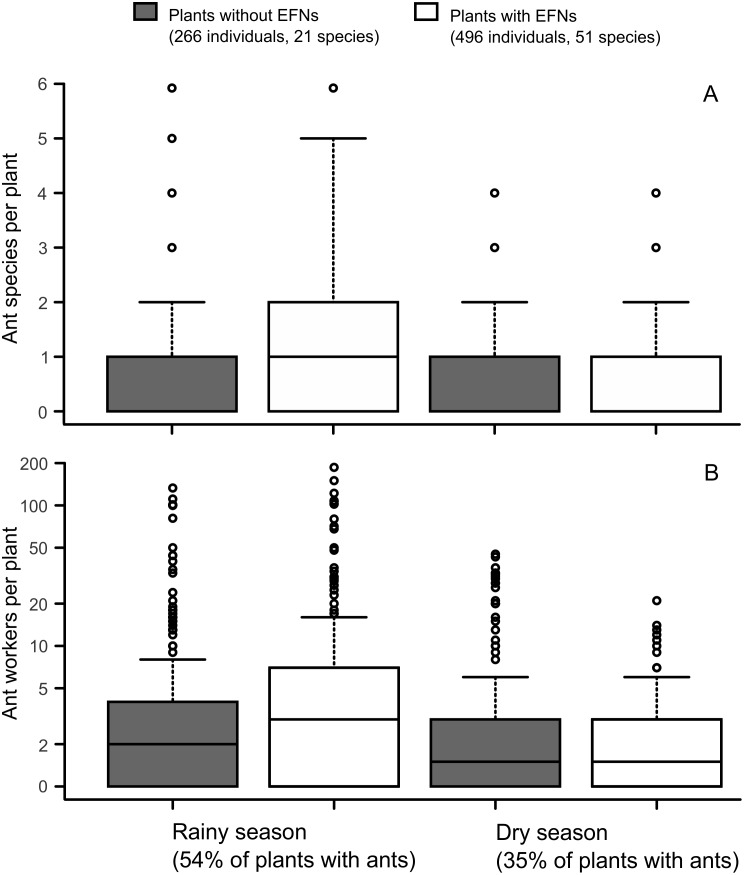
Seasonal ant visitation patterns on Cerrado plants with and without EFNs.Number of ant species (A) and ant workers (B) per plant. Black horizontal lines represent the median, boxes designate the second and third quartiles, and vertical bars indicate the range of data without outliers. Asterisks indicate significant differences (P < 0.5) between adjacent pairs of categories following contrast procedure.